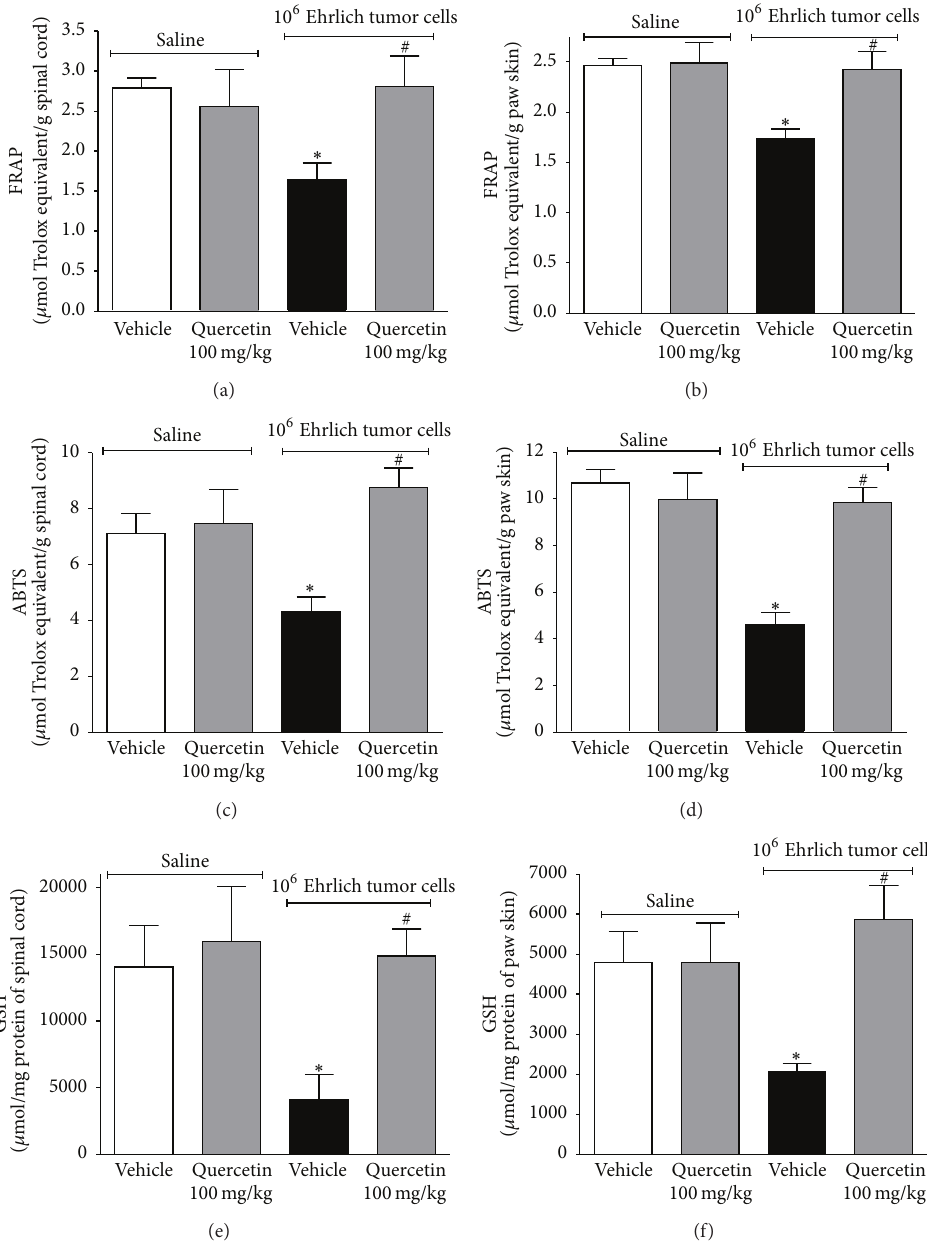
Figure 6: Quercetin inhibits the oxidative stress induced by Ehrlich tumor cells. Mice were treated with quercetin (100mg/kg, i.p.) or vehicle 10min after the injection of Ehrlich tumor cells (1 × 10 6 /25 𝜇 L) or saline. The treatment continued daily during 12 days, and, in the 12th day, 3 h after the treatment, samples of spinal cord and paw skin were collected for the oxidative stress assays. The FRAP and ABTS ability of spinal cord ((a) and (c), resp.) and paw skin ((b) and (d), resp.) tissues and GSH levels in spinal cord (e) and paw skin (f) were accessed. Data are presented as means ± SEM of six mice per group per experiment and representative of two separated experiments: ∗ 𝑝 < 0.05 compared to the saline group and # 𝑝 < 0.05 compared to the tumor group. One-way ANOVA followed by Tukey’s test.